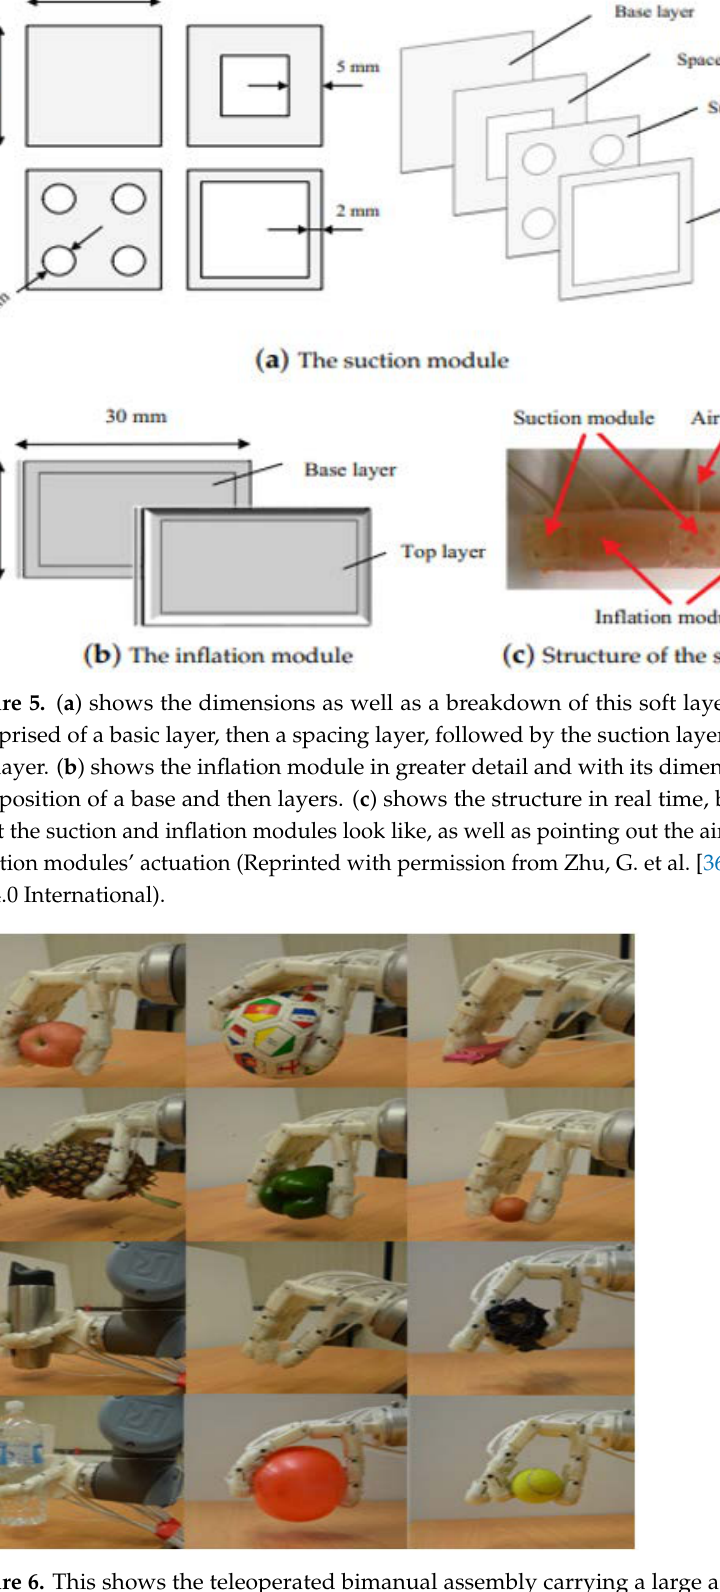
Figure 6. This shows the teleoperated bimanual assembly carrying a large assortment of different shapes and sizes to show how well it can grip with its soft layer and cumulative hand strength (Reprinted with permission from Zhu, G. et al. [36]. Copyright 2020, CC BY 4.0 International).